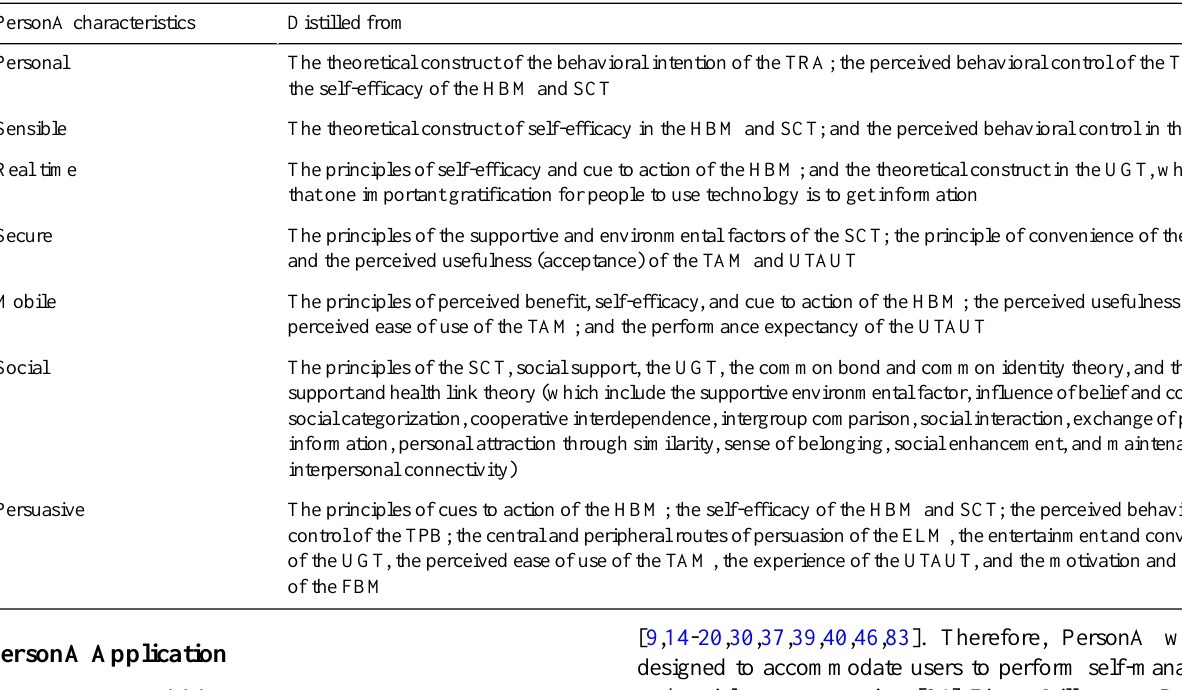
Table 1. PersonA characteristics and the established health behavior change theories which include, the HBM, the TRA / TPB, the ELM, the SCT, the social support and health link theory, the UGT, the CBCI theory, the TAM, the UTAUT, and the FBM. Distilled fromPersonA characteristics The theoretical construct of the behavioral intention of the TRA; the perceived behavioral control of the TPB; and SCTPersonal the self-efficacy of the HBM and